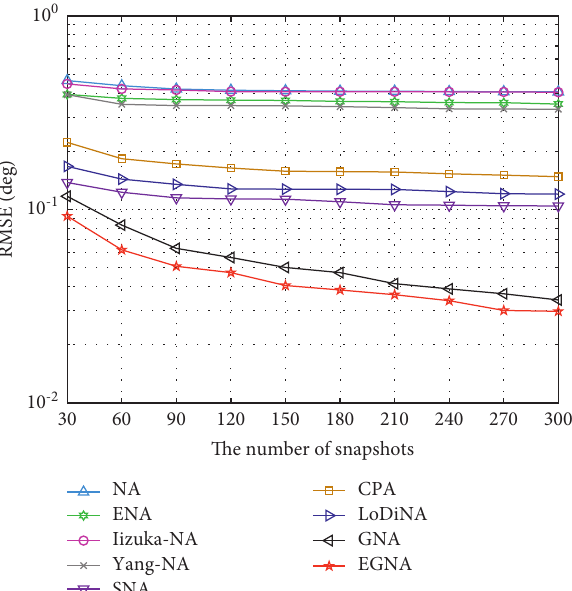
Figure 11: RMSE versus the number of snapshots for different array